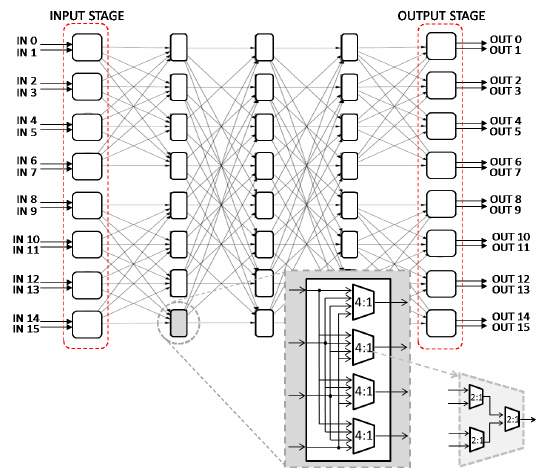
Figure 6. An example of radix-4 16 × 16 flat